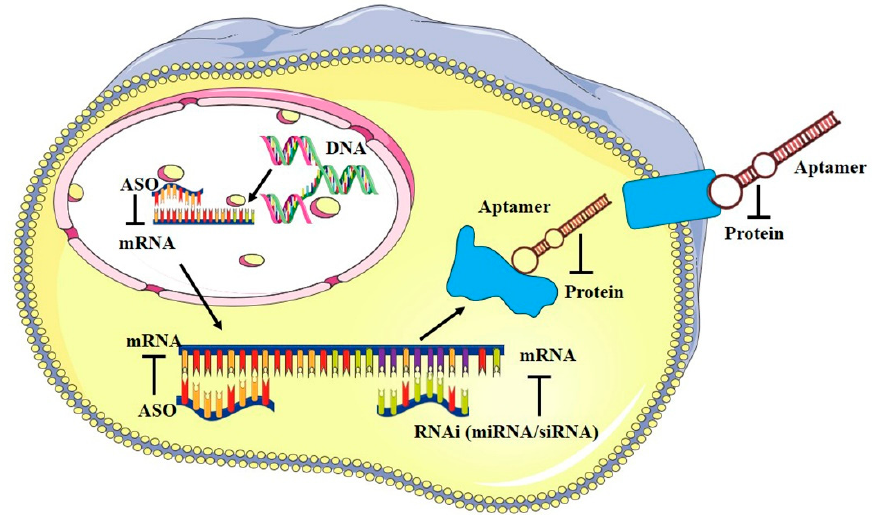
Figure 1. RNA-based therapeutics general mechanism of action. Scheme of the main mechanism of action of small RNA-based therapeutics: ASOs, miRNAs, and siRNAs bind to mRNA preventing proteins translation; aptamers bind their target protein by folding into complex tridimensional shapes.